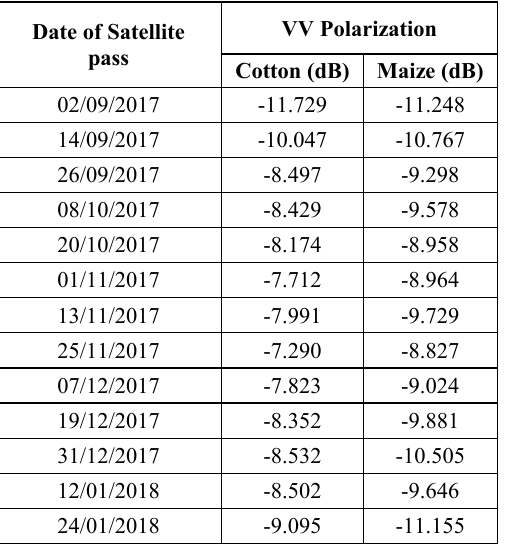
Table-1: Temporal backscatter signature for maize and